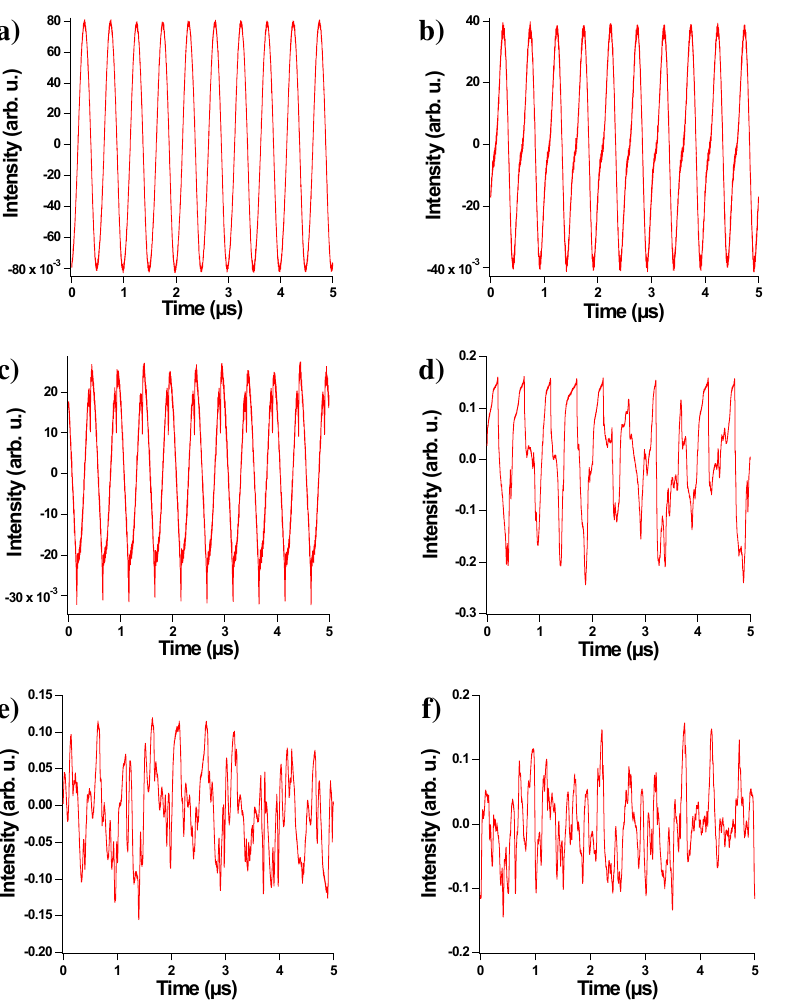
Figure 4. Experimental timetraces representing the various dynamics that can be generated by the QCL under strong reinjection and periodic forcing. ( a ) Stable sine wave (S). ( b ) Sine wave with distortion (Sd). ( c ) Entrainment phenomenon (E) with synchronization of the dropouts with the sine wave. ( d ) Complex chaos dynamics are now found in the time trace, in competition with the sine wave with distortion (CC + Sd). ( e ) Chaos dynamics have a magnitude comparable with the entrainment phenomenon (CC + E). ( f ) Coherence collapse chaos dynamics are the only distinguishable phenomenon in the waveform